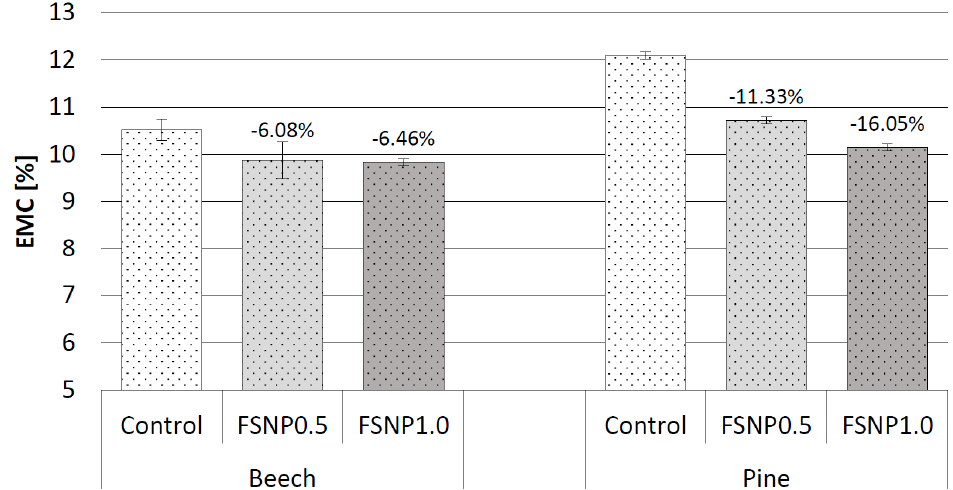
Figure 8. Equilibrium moisture content of FSNP-treated beech and Scots pine wood (percentages show the difference to the control and whiskers the standard deviation of the results).